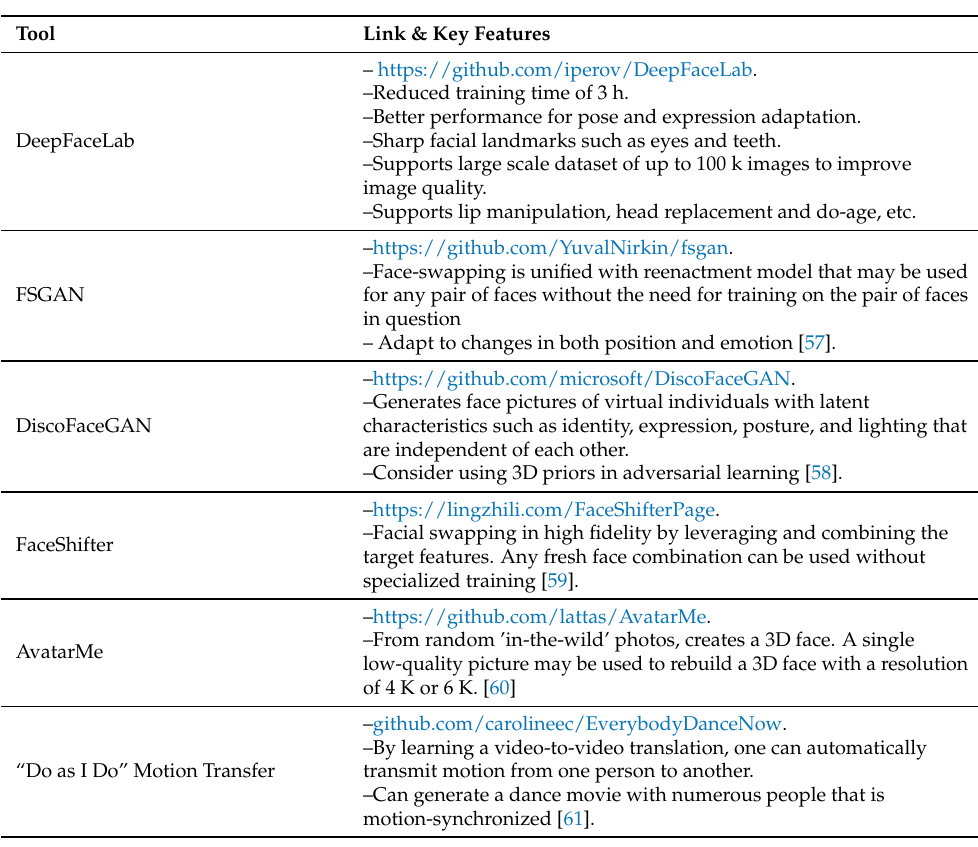
Table 3. Brief overview of deepfake face